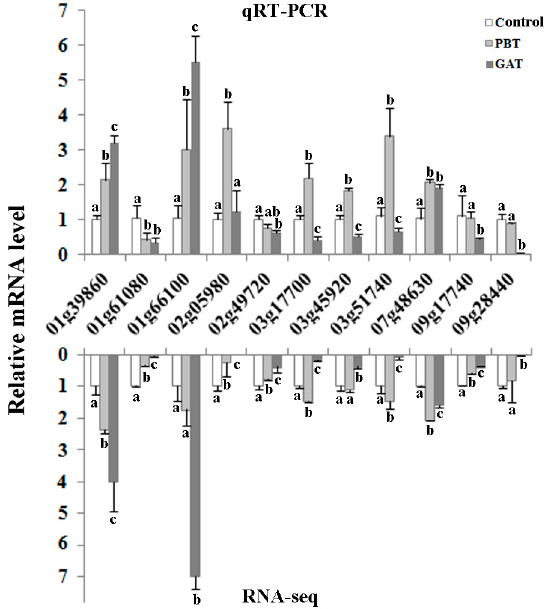
Figure 5. qRT-PCR validation of the DEGs in RNA-seq results. All values are based on three technical repeats and presented as means ± SD. Different characters indicate a statistically significant difference at p < 0.05 by t -test.